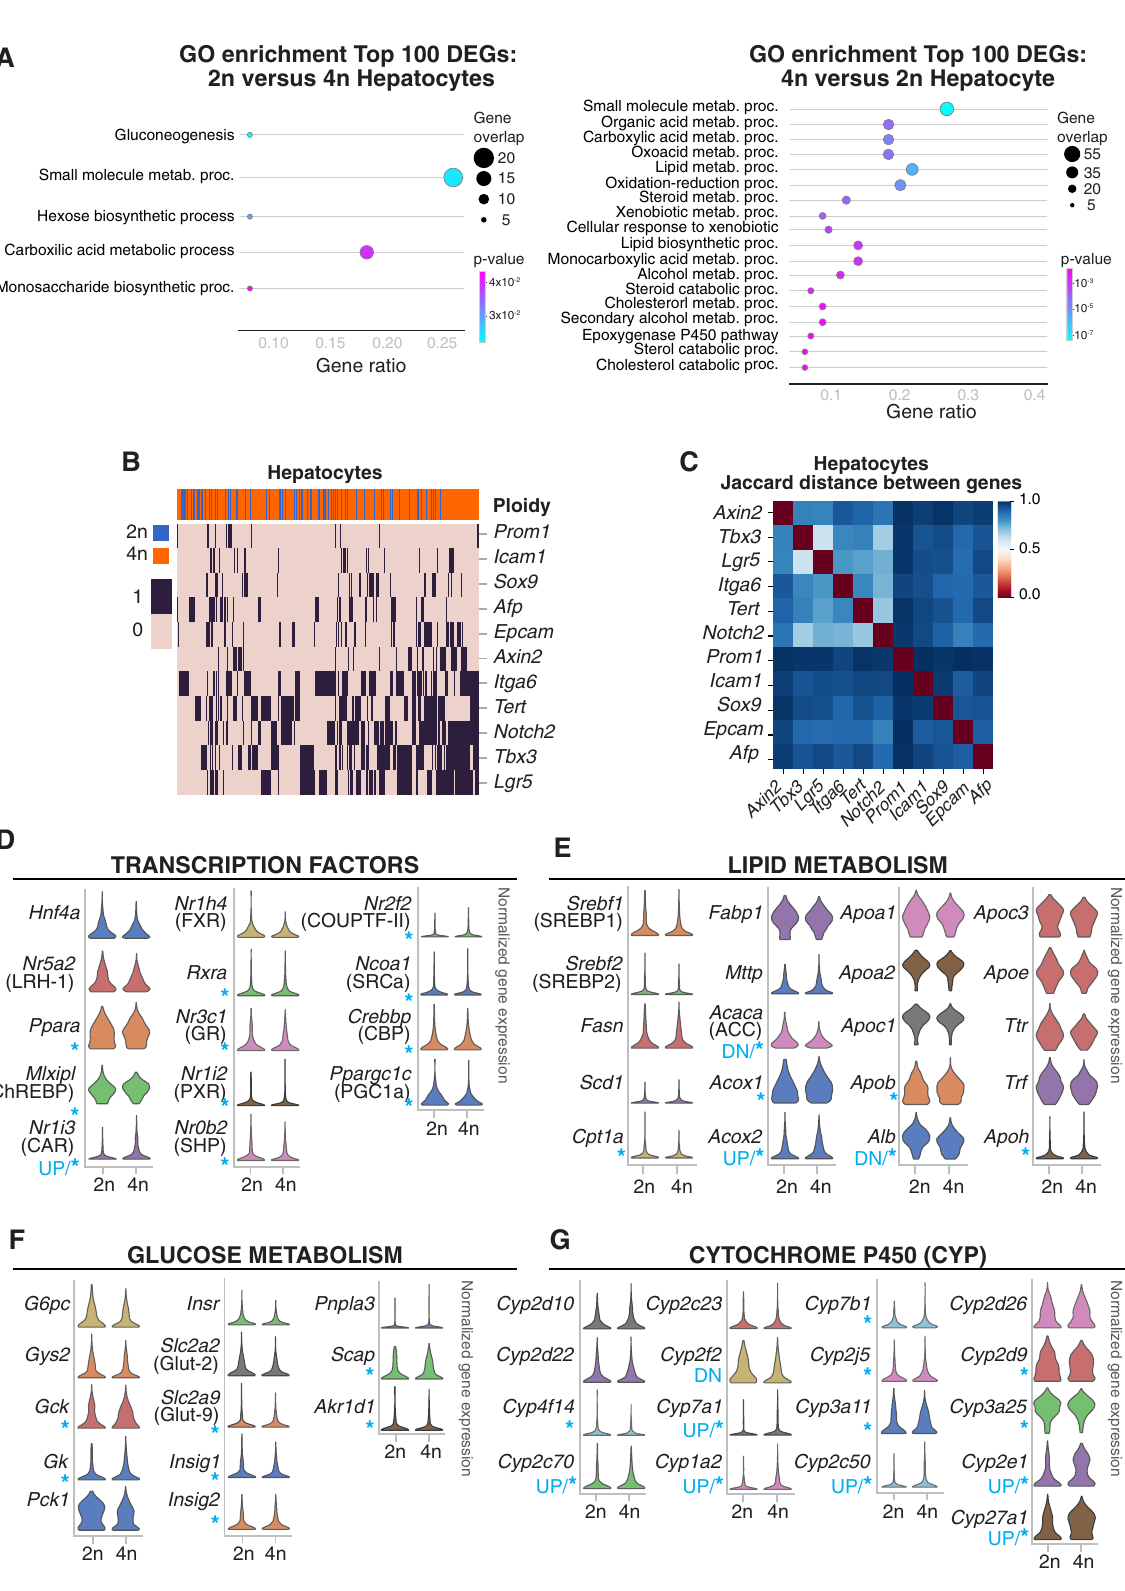
(Fig. 4B and Supp. Fig. 7B). Five of these markers, Notch2 , Tbx3 , Itga6 , Lgr5, and Tert were expressed in more than 40% of the nuclei analyzed (Supp. Fig. 7C). While we observed that both 2n and 4n hepatocytes expressed several stem/progenitor markers, we did not fi nd an enrichment of those genes in diploid